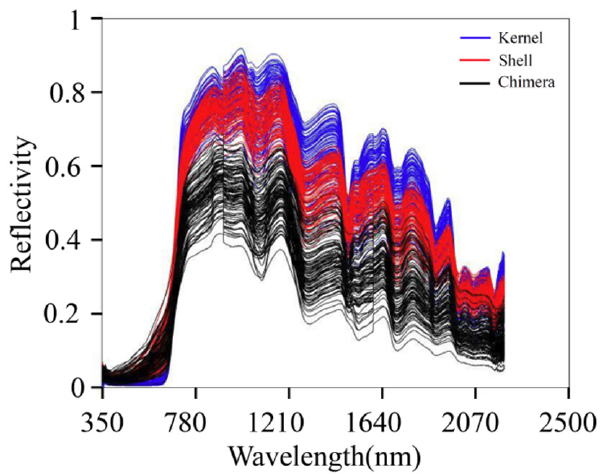
Figure 3. Original spectra.